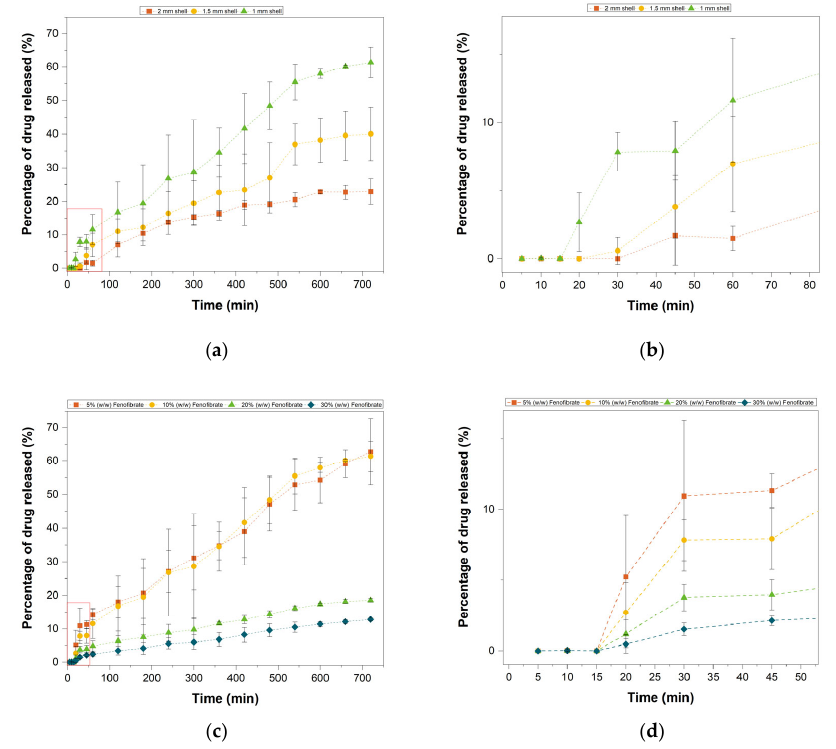
Figure 11. In vitro dissolution test of Delayed release tablets. ( a ) Tablets with single fixed core geometry and variation in shell thickness (1 mm, 1.5 mm and 2 mm). ( b ) Highlight of the initial delay in drug release. ( c ) Tablets with 1 mm shell and various drug concentration in the core (5%, 10%, 20% and 30% w / w Fenofibrate). ( d ) Highlight of the initial 15 min delay in drug release.